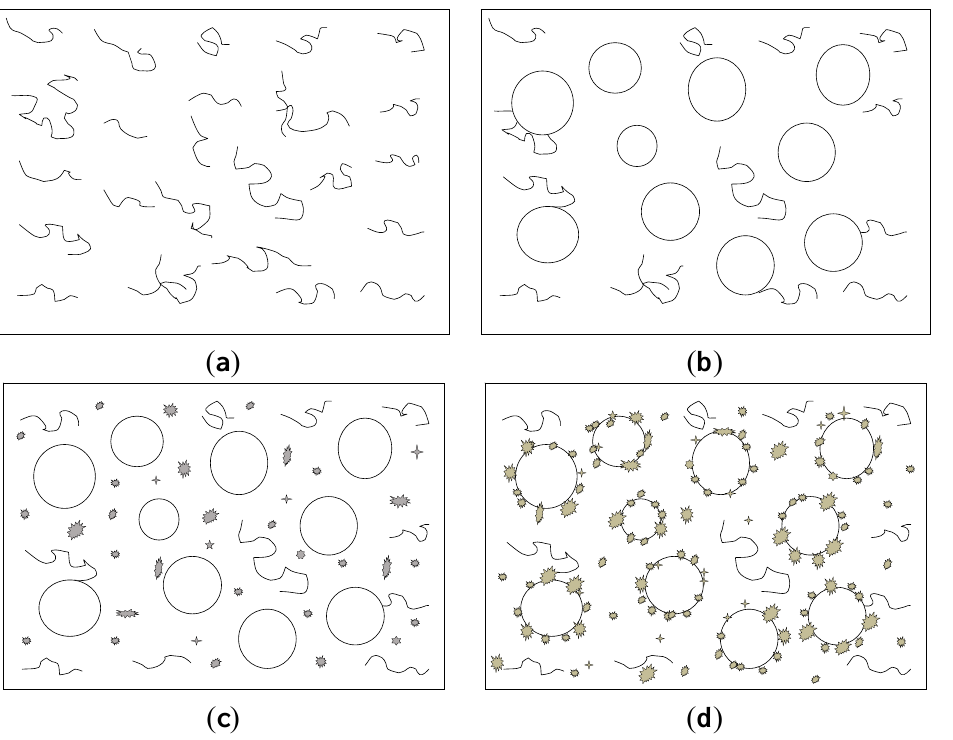
Figure 1. Synthesis stages of organic microcapsules. ( a ) Pre-polymer prepared; ( b ) Core material dispersed into droplet; ( c ) Pre-polymer polycondensated and ( d ) Polycondensated pre-polymer deposited on